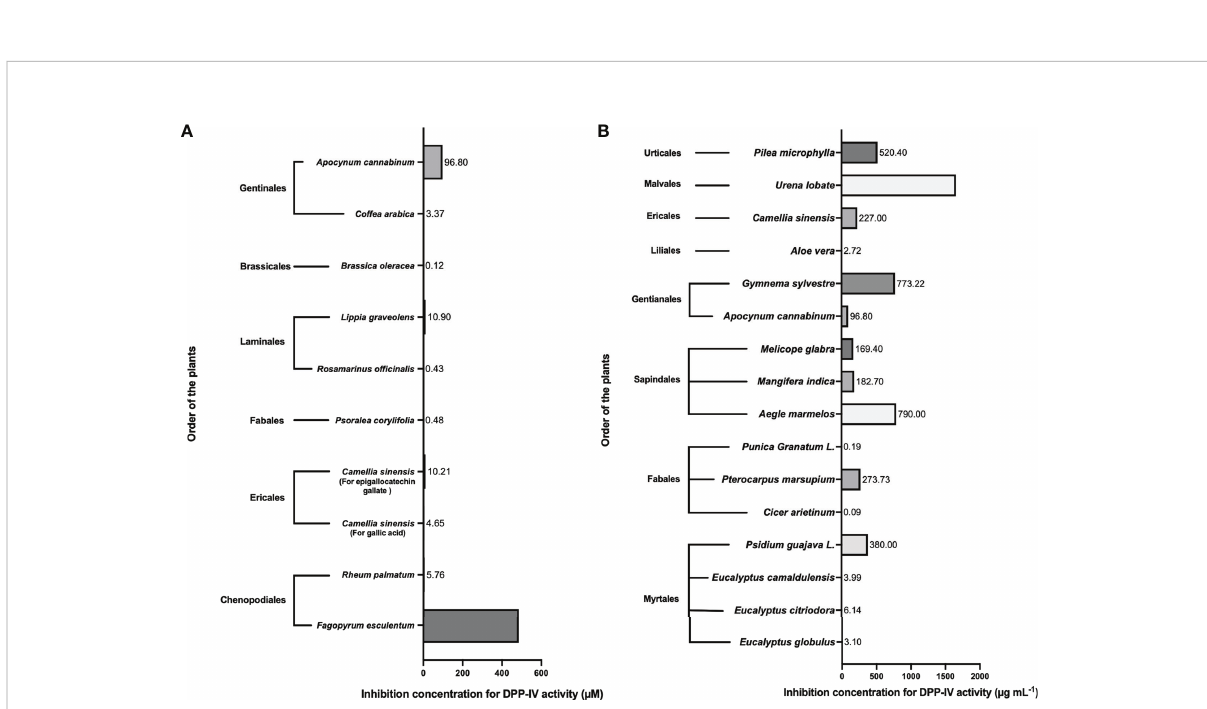
FIGURE 3 Levels of dipeptidyl peptidase (DPP)-IV activity inhibition concentration of bioactive compounds in certain plants studied. Different inhibitory concentrations of the plant products are found for the inhibition of DPP-IV (13 – 28). In (A) , the inhibitory concentration is evaluated in m M, while in (B) the inhibition concentrations are emulated in m g/ml.